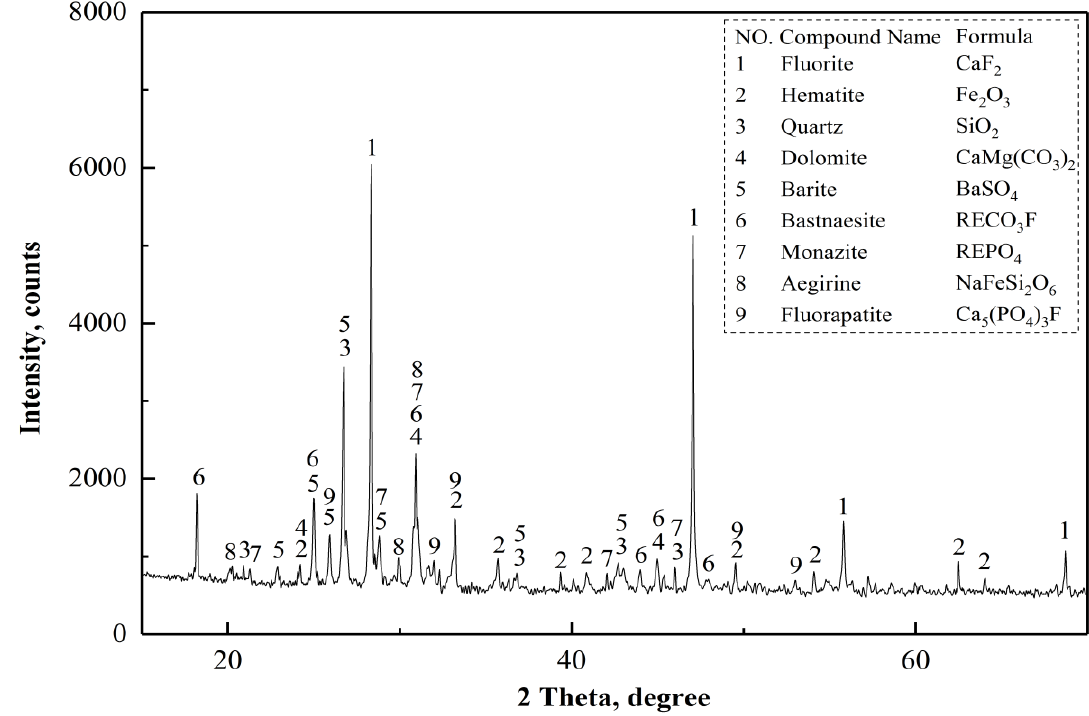
Figure 5. X-ray diffraction (XRD) patterns of Bayan Obo tailings.